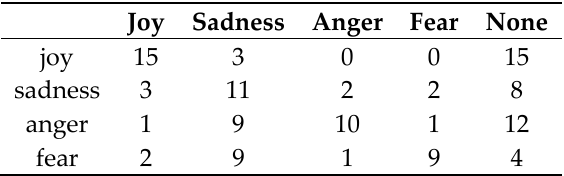
Table 1. Confusion matrix, where the first row contains the expected emotion, and the first column contains the detected emotion.